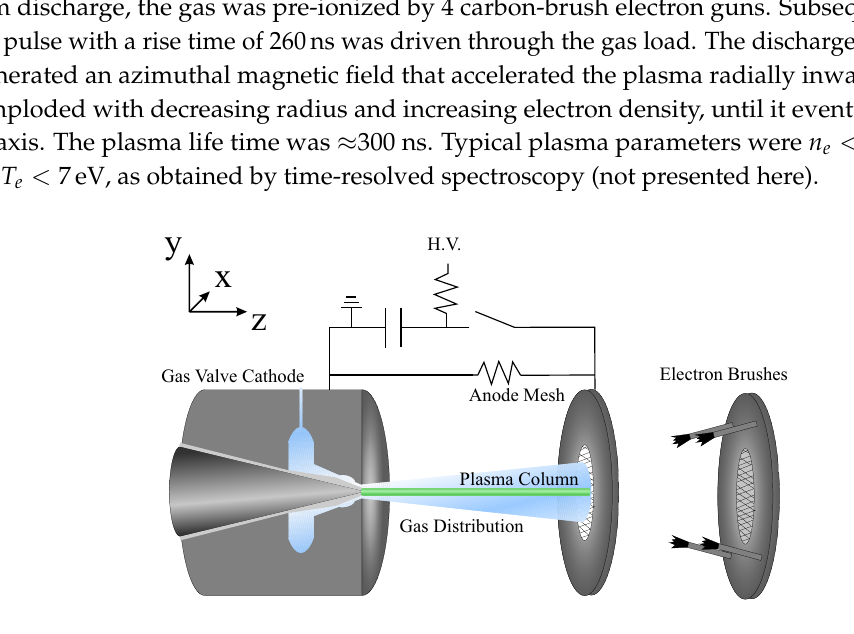
Figure 1. Plasma generation